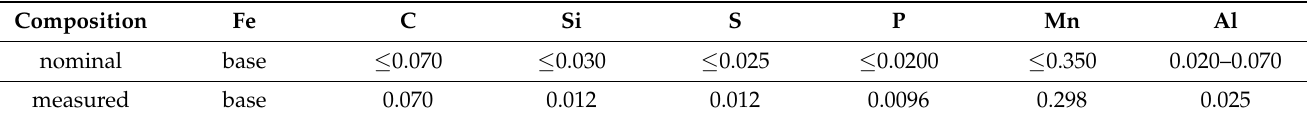
Table 1. Nominal and measured chemical composition (wt.%) of 08YU steel